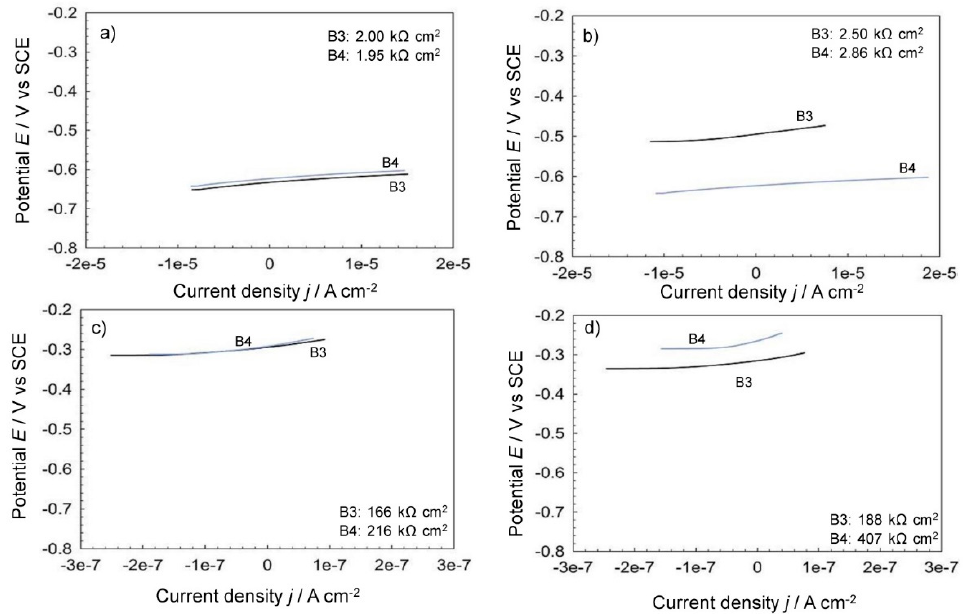
Figure 2. Linear polarization measurements of steel samples B3 (conventional heat treatment) and B4 (deep cryogenic treatment) conducted in four different test solutions: ( a ) 0.1 M NaCl; ( b ) Na-tetraborate buffer pH 10 and 0.1 M NaCl; ( c ) Na-tetraborate buffer pH 10, and 1 mM NaCl; ( d ) Na-tetraborate buffer pH 10 without chlorides.